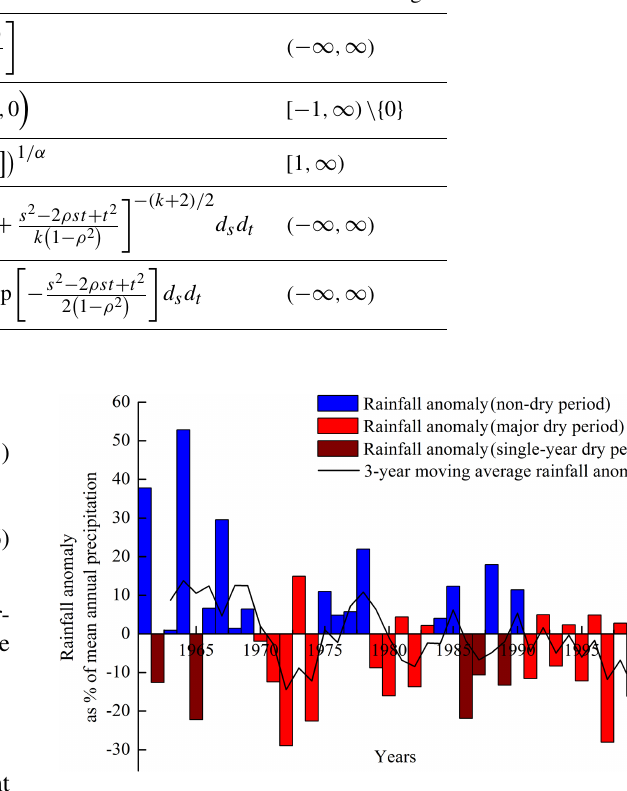
Figure 2. Time series with identified drought periods on the Loess Plateau during